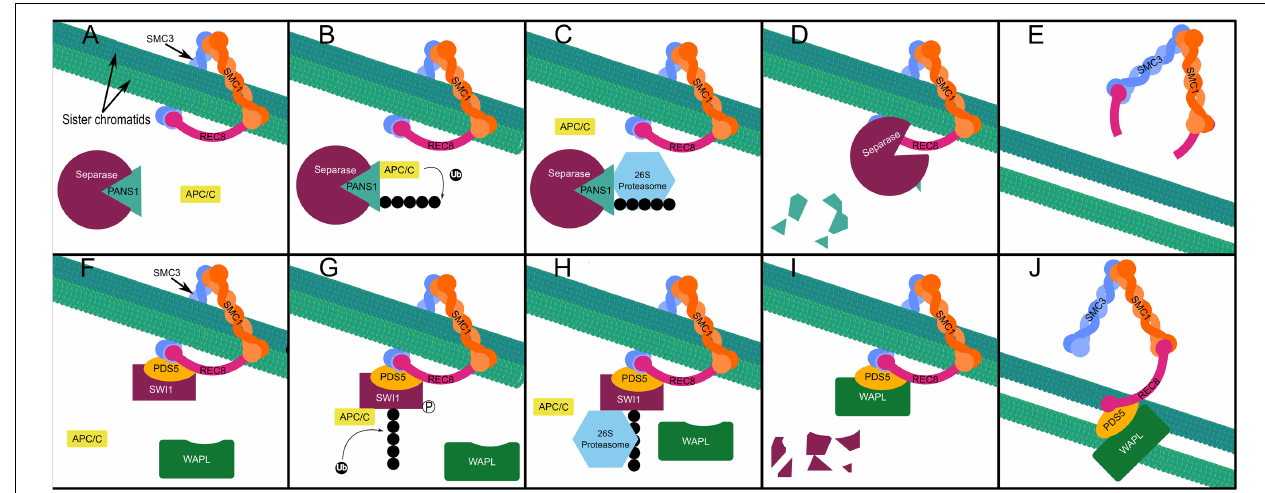
FIGURE 5 | Proteolytic cohesin removal (A–E) . Separase is inhibited by PANS1 protecting REC8 from proteolytic cleavage at chromosome arms preceding anaphase I and at the centromere preceding anaphase II redundantly and in parallel with SGO (A), APC/C mediated ubiquitination of PANS1 (B) , triggers its proteasomal degradation (C,D) , freeing separase (D) to cleave Rec8, the kleisin subunit of the cohesin ring, allowing sister chromatid separation in anaphase II (E) . Non-proteolytic (prophase pathway) cohesin removal (F–J) . SWI1 associates with cohesin beginning at interphase and inhibits the interaction of WAPL with PDS5 (F) . Phosphorylation of SWI1 enables APC/C mediated ubiquitination (G) . Proteasomal degradation of ubiquitinated SWI1 (H–I) , enables WAPL to interact with PDS5 (I) , triggering non-proteolytic “opening” of the cohesin ring complex and sister chromatid release from the onset of zygotene stage to the end of pachytene stage in prophase I (J)